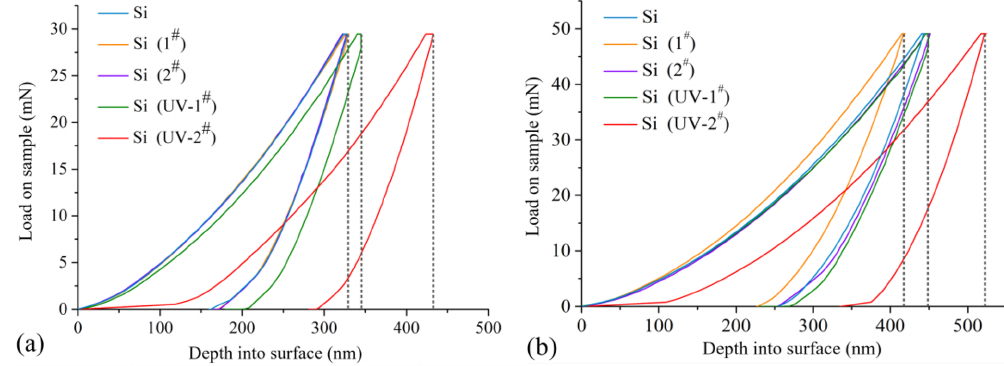
Figure 4. The load–depth curve of nanoindentation samples of the (a) 30mN load and the (b) 50mN load.